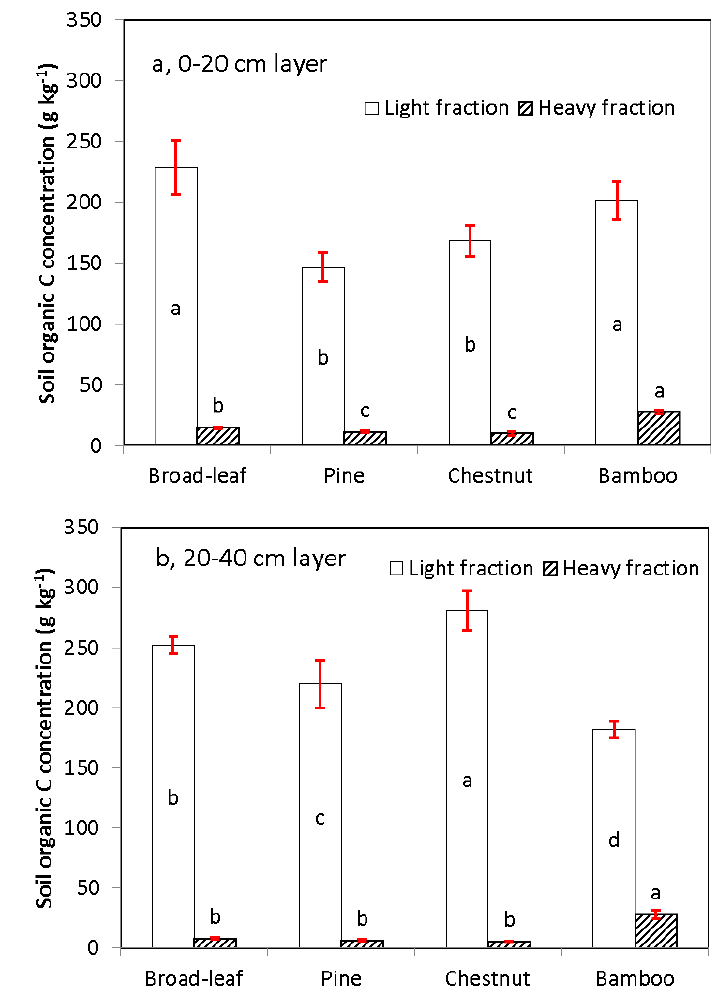
Figure 3. Soil organic carbon in light and heavy fractions in the ( a ) 0–20-cm layer and ( b ) 20–40-cm layer under four types of forest vegetation-land use. Soil organic C concentrations are per soil fraction mass. Means labeled with different lowercase letters are different between the vegetation-land use types within each density